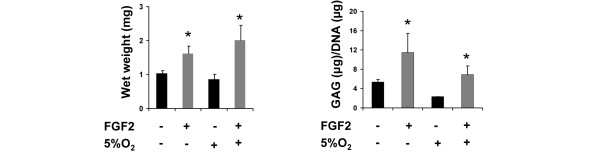
Weights and GAG per DNA content of cell aggregates. Wet weights of cell aggregate derived from non-FGF2-expanded (black bars) and FGF2-expanded (grey bars) meniscus cells under normoxia (-) or hypoxia (+), and GAG content of cell aggregate normalised to DNA content. FGF2, fibroblast growth factor 2; GAG, glycosaminoglycan.